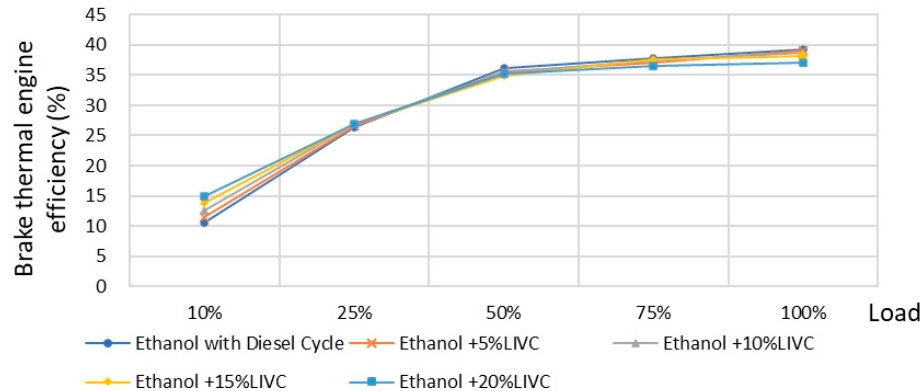
Figure 21. BTEE(%) of ethanol engine with LIVC Miller Cycle.